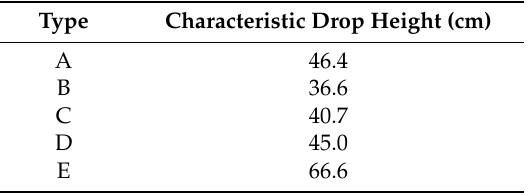
Figure 9. The drop-weight tests data points of the five types of PTFE/Al/TiH 2 composites: ( a ) type A; ( b ) type B; ( c ) type C; ( d ) type D; ( e ) type E. Table 4. The characteristic drop height of impact sensitivity ( H 50 ) for the five types of PTFE/Al/TiH 2 composites.